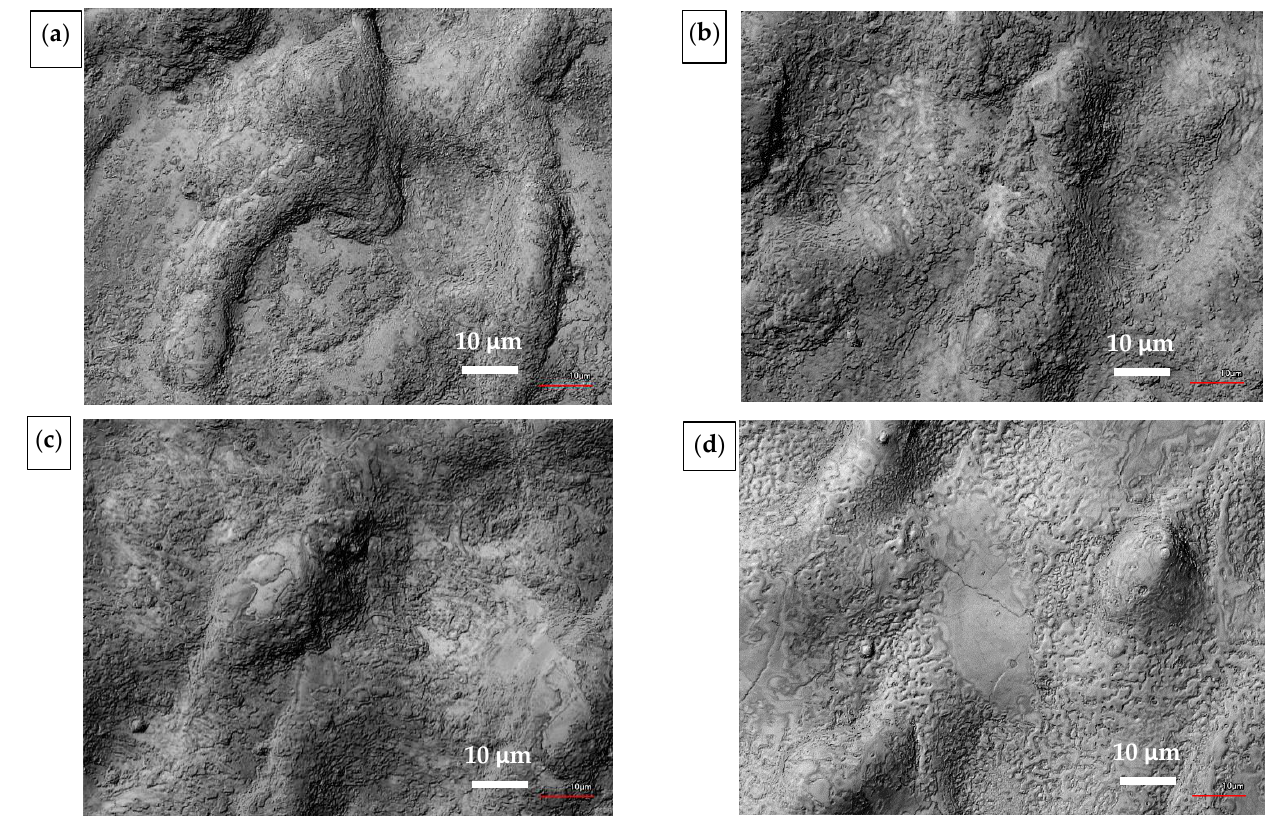
Figure 10. SEM images of stripped samples: ( a ) DLC1; ( b ) DLC2; ( c ) DLC3; ( d ) DLC4.